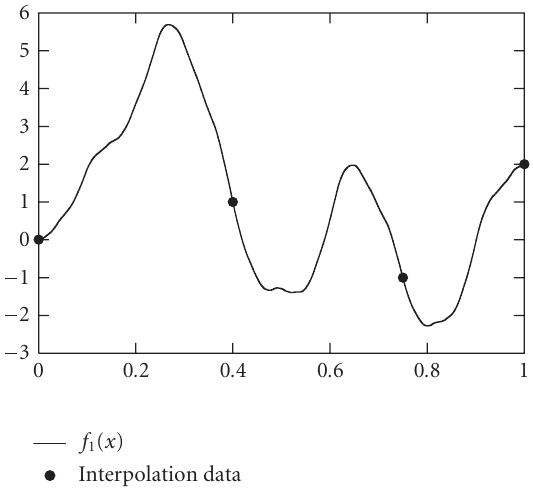
Figure 5.6. E ff ect on spline CHFIF by a change in the hidden variables z n .